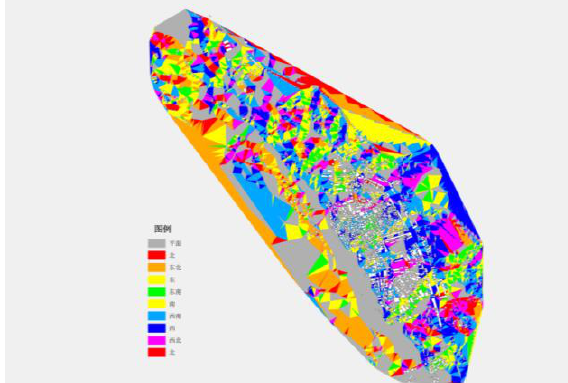
Figure 2. The aspect analysis for interpretation of the historical information